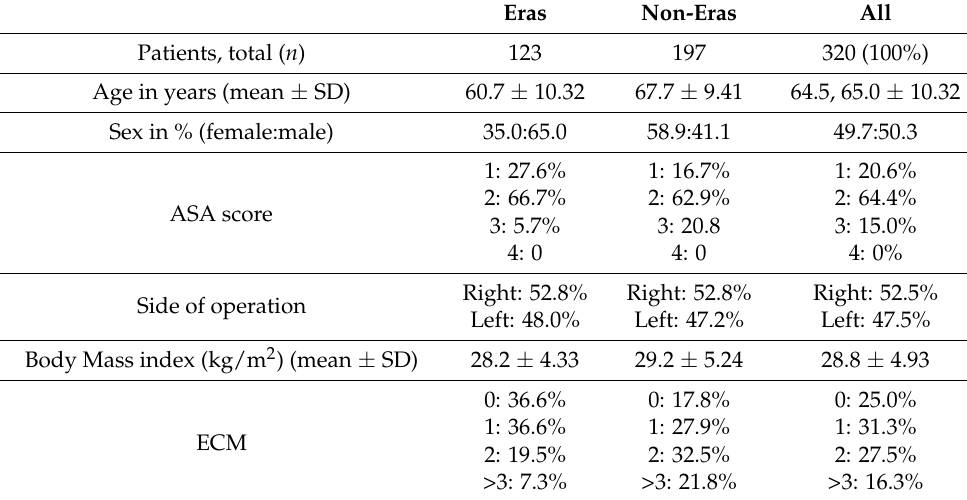
Table 1. Demographic and general data before matching.